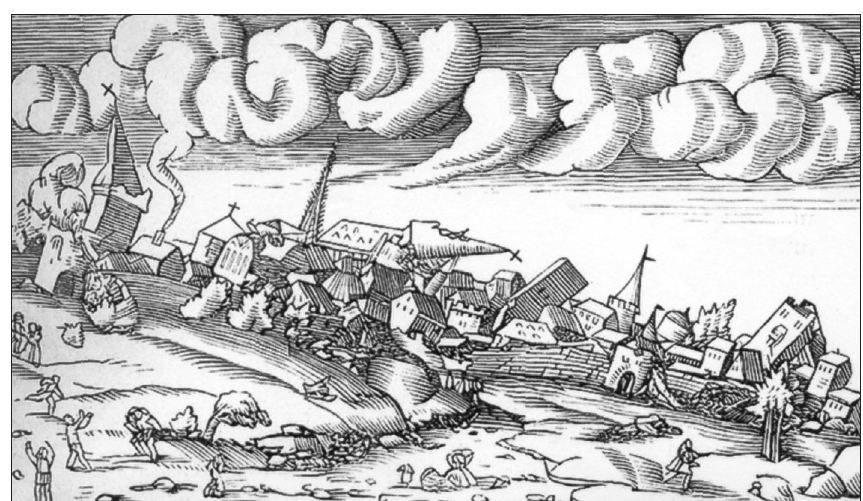
Fig. 2. Illustration (Münster, 1550) of a dramatic situation in which a town is severely affected by an earthquake. Lycosthenes (1557) used this woodcut in connection with his description of the 1356 Basel earthquake – but for many other earthquakes as well ( cf. text). It is therefore not likely that the town Basel its depicted, as assumed by some modern